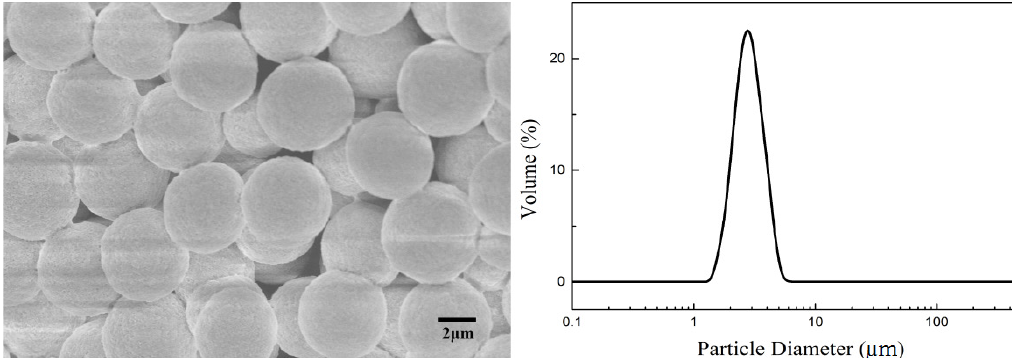
Figure 8: SEM image and particle size distribution of ordered mesoporous silica microspheres